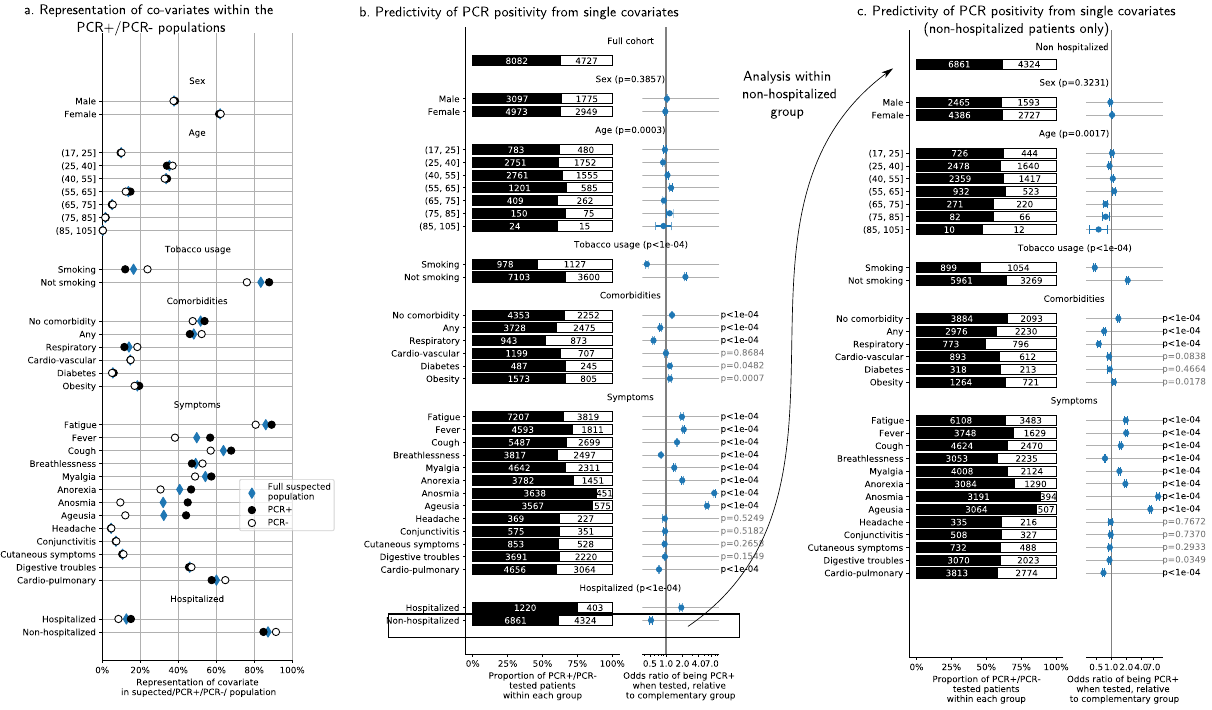
Figure 2. Effects of patient characteristics on RT-PCR results. We apply a propensity-scoring weight to each patient, to remove the testing-propensity confound. We report weighted counts/proportions/odds-ratios. ( a ) Representation of each characteristic in the whole cohort (blue diamonds), the RT-PCR+ cohort (black dot) and the RT-PCR− cohort (white dot). ( b ) RT-PCR results as a function of different characteristics in the tested population (cf Fig. 1c for categories). Odds ratios of being RT-PCR+ when belonging to a given subgroup, and p-values that these ratios are significantly different from 1 (using a Wald test). Patients without comorbidities nor smoking are more likely to be RT-PCR+, so do patients with anosmia, ageusia, anorexia, fever, fatigue, cough, myalgia. On the opposite, comorbidities, in particular respiratory diseases, and symptoms such as breathlessness and cardiopulmonary symptoms are associated with RT-PCR. ( c ) Same analysis as ( b ), within the subpopulation that has not been hospitalized. Results are similar. Table S1 provides all numerical